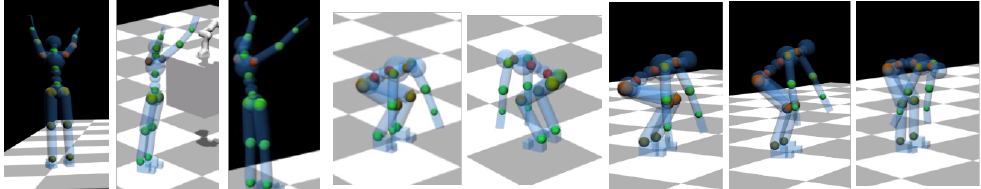
Figure 11. Experiment 1: pick and place. Across the pick and place task, the human takes on different postures. In particular, some are usually classified as non-ergonomic (e.g., hands over shoulders, bent back, squat). The color-coded spheres on the DHM show the body parts that have a high risk (ergonomics score: RULA) during these